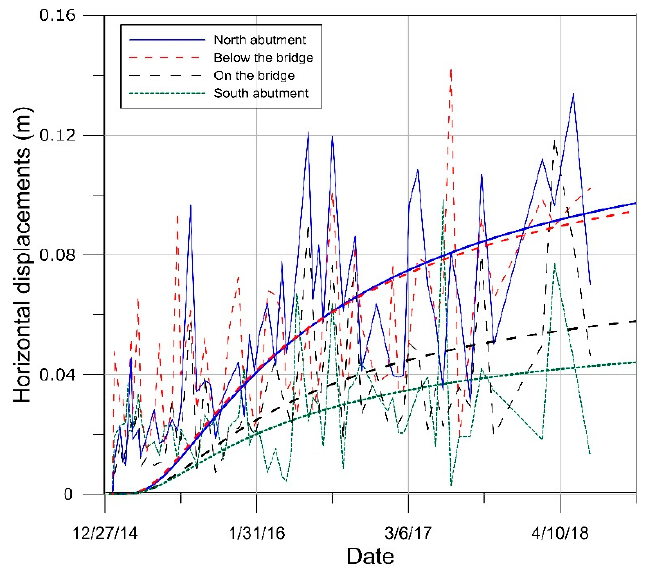
Figure 10. Average horizontal displacements evolution of the control points sorted by its location: ( a ) north abutment, ( b ) On the bridge pavement, ( c ) below the bridge (upper side of the cap piles), and ( d ) south abutment.